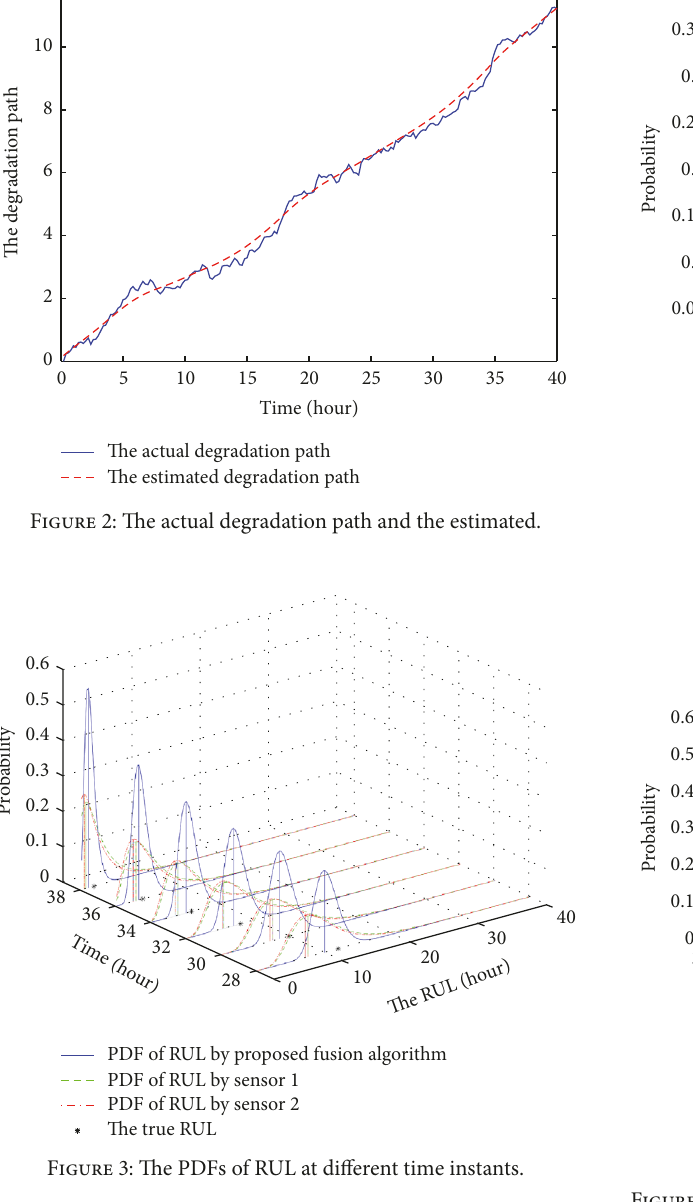
Figure 5: Comparison of the proposed algorithm and the approach in [18] under synchronous